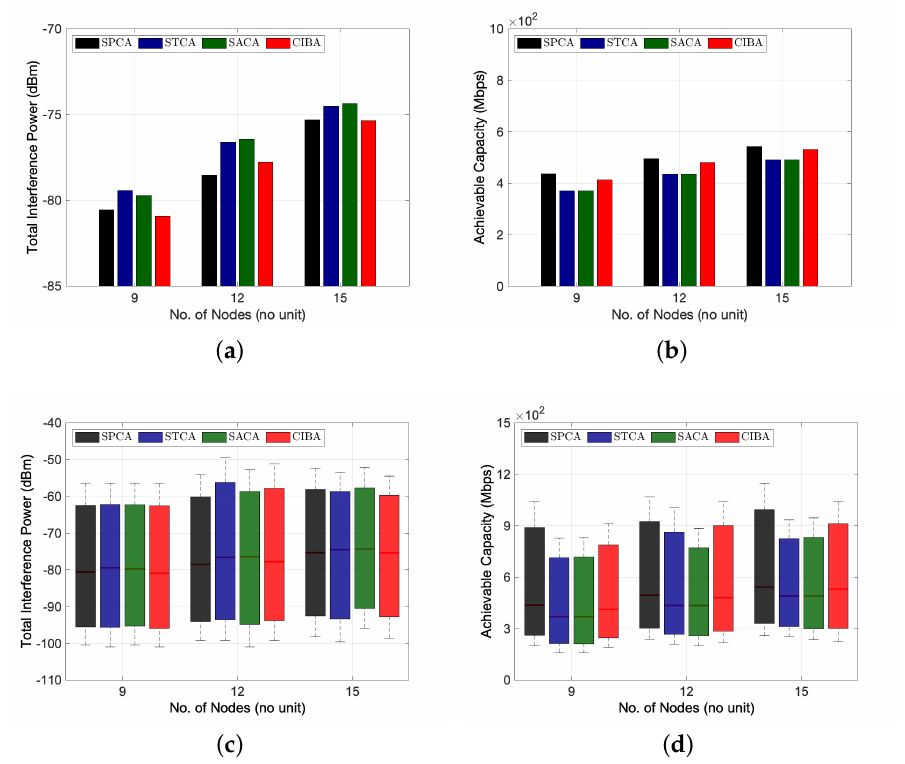
Figure 7. Performance comparison between fixed channel allocation and CIBA algorithms by con- sidering multi-channel FD multihop wireless network environments. ( a ) Performance results for average total interference power versus the number of nodes; ( b ) Performance results for average achievable capacity versus the number of nodes; ( c ) Distribution of total interference power versus the number of nodes; ( d ) Distribution of achievable capacity versus the number of